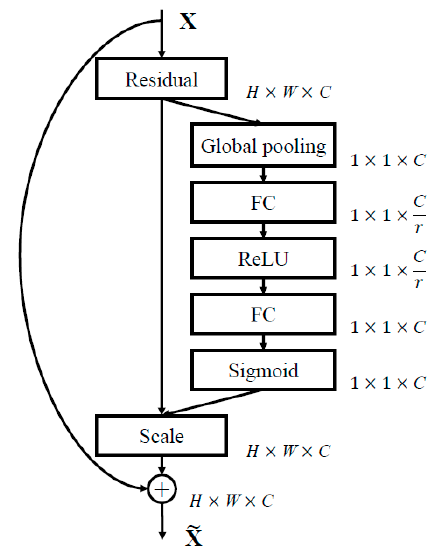
Figure 9. Channel attention-based ResNet residual module [34]. The global pooling layer and fully connected layers were added to the residual module to calculate the excitation parameters, and the features with channel attention were obtained from multiplied original features with excitation parameters.